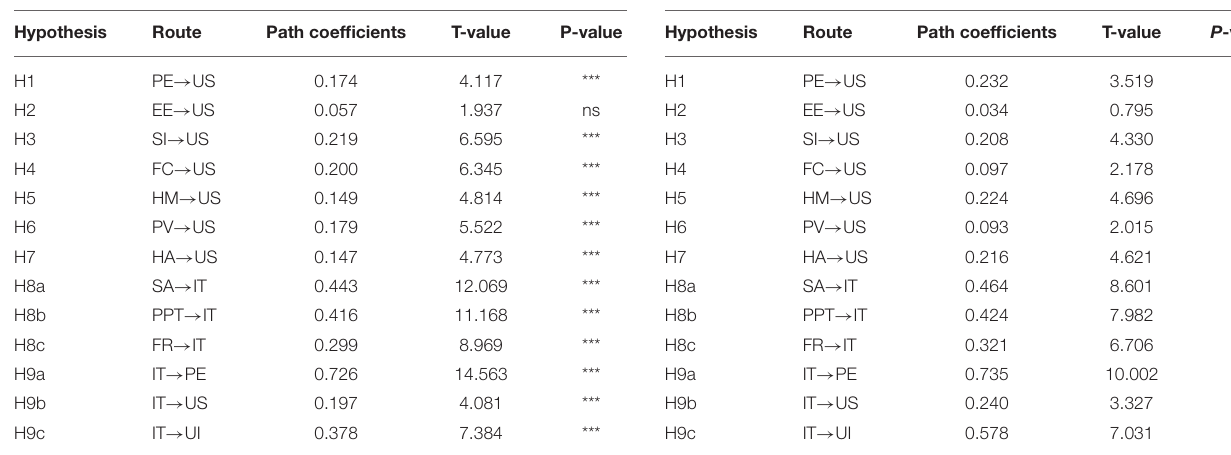
TABLE 6 | Results of hypotheses tests (China users’